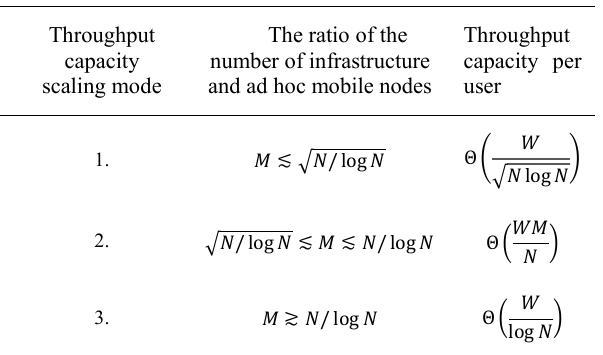
Table 2. Scaling modes [16]